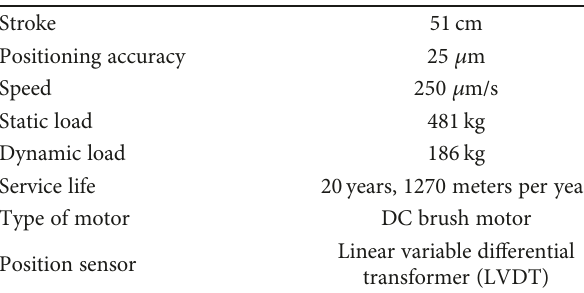
Table 5: Design parameters of GBT